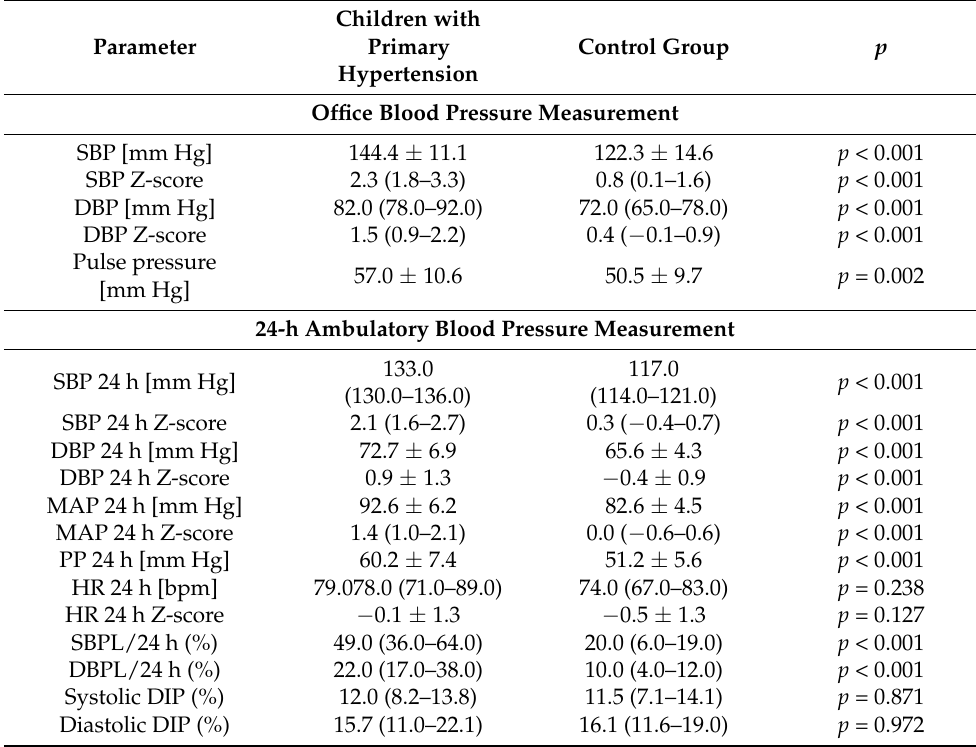
Table 3. Arterial hypertension in the examined population—office measurement and ambulatory blood pressure monitoring